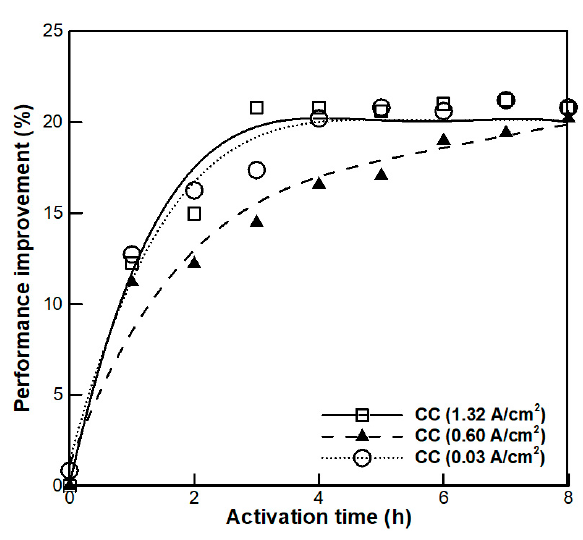
Figure 3. Performance improvement of constant current (CC) mode conditioning depending on activation